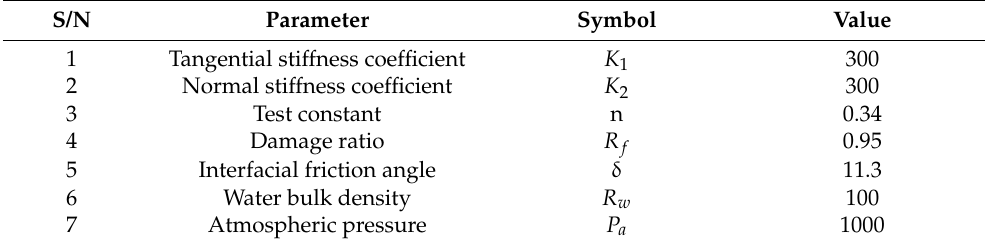
Table 2. Parameters of Goodman element between the polymer and the dam body.